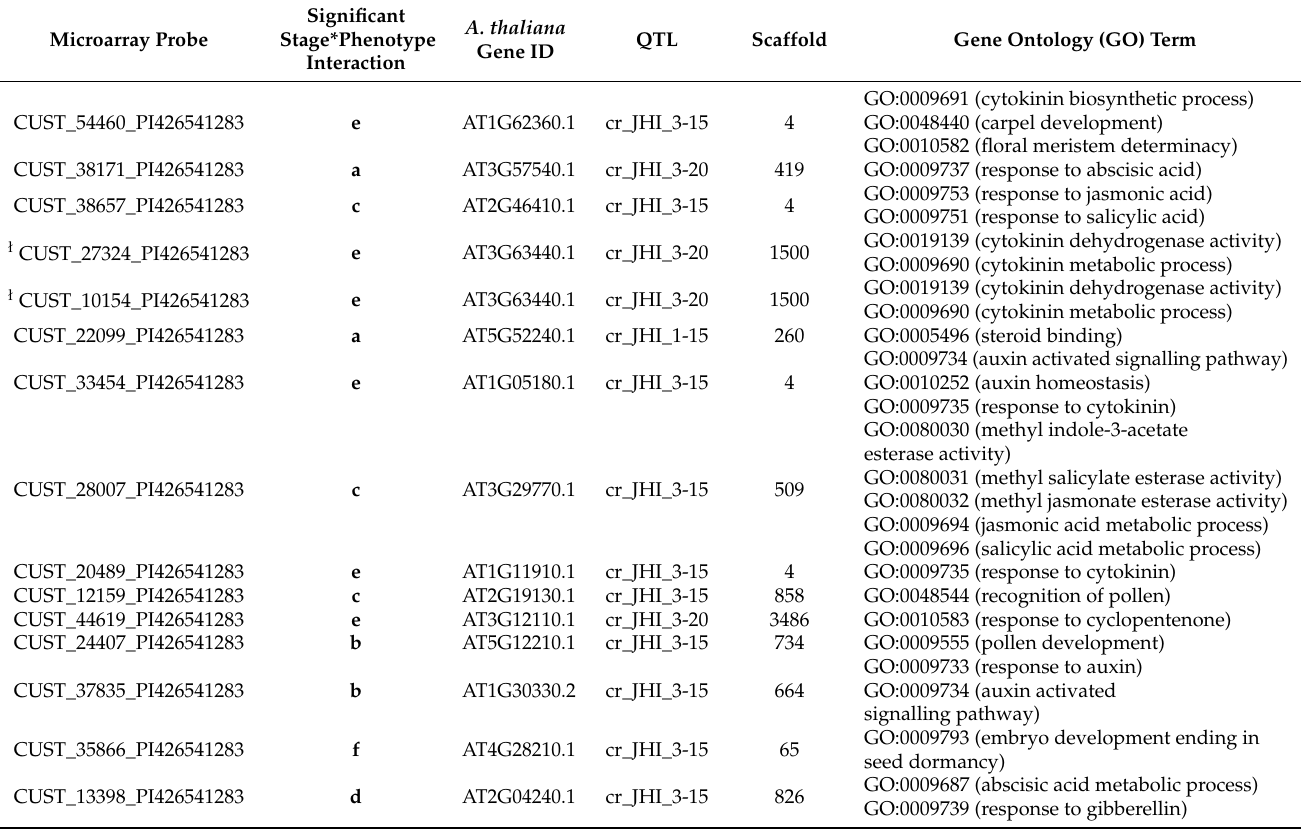
Table 2. List of 15 microarray probes within the Glen Moy genome scaffolds located within the three crumbly QTLs on linkage group 1 and 3. The 15 probes are listed in the same order of the tree cluster heatmap of Figure 2. These probes have A. thaliana ortholog gene ontology (GO) annotation related to hormones, pollen, or flower development. cr_JHI_3–20 indicates the crumbly QTL identified during this work on linkage group 3 while cr_JHI_1–15 and cr_JHI_3–15 indicate the original crumbly QTLs identified on linkage group 1 and 3 by Graham et al. [1]. The stage/s to which a significant difference (stage*phenotype interaction p < 0.001) between the two phenotypes tested is found, are indicated with bold lowercase letters as follows: a = only closed bud, b = open flower, c = green berry, d = closed bud and open flower, e = closed bud and green berry, f = open flower and green berry, and g = closed bud, open flower, and green